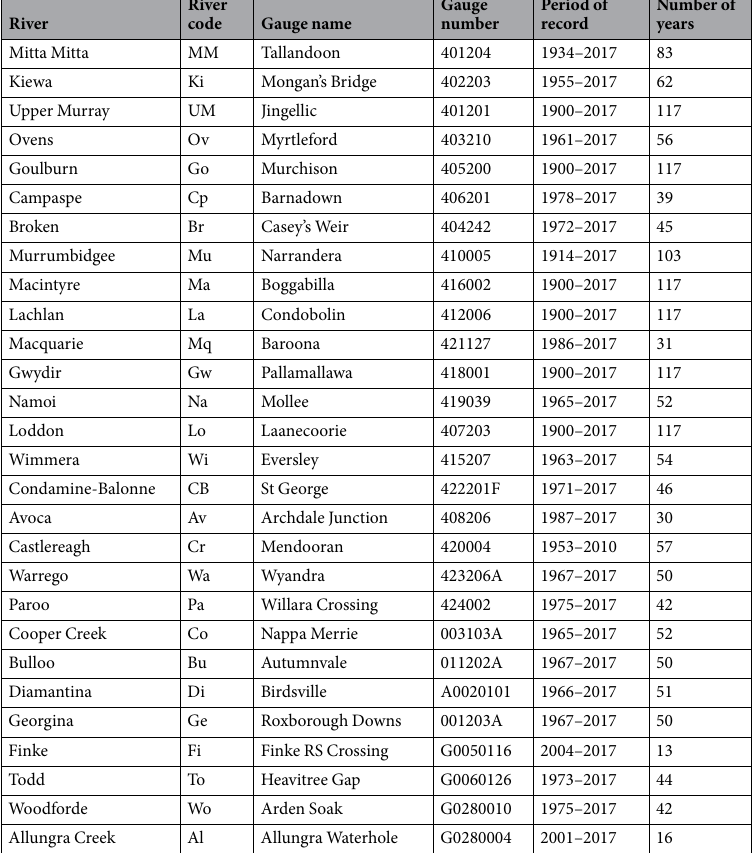
Table 3. Rivers with stream gauges (n = 28) used for hydrological analysis in this study (see Fig. 2). The Hay River does not have a suitable